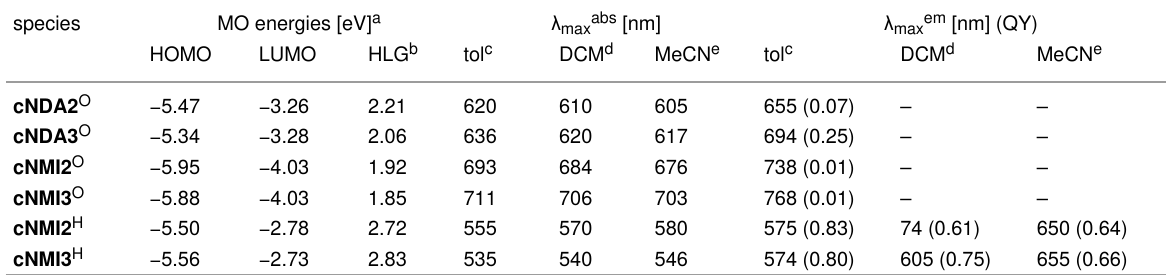
Table 2: Experimental and calculated a properties of fused bipyrroles. species